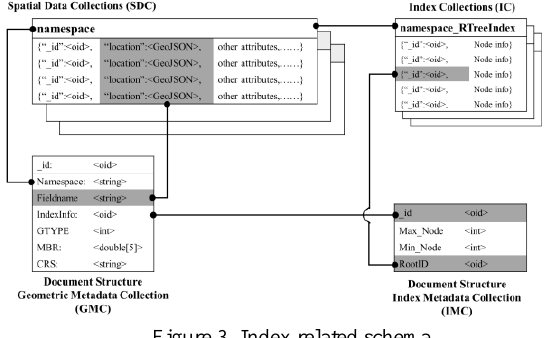
Figure 3. Index related schema